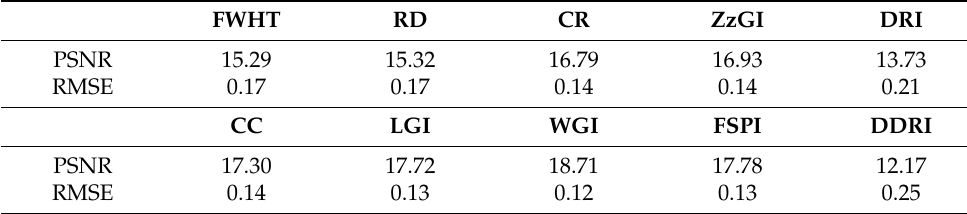
Table 6. PSNR and RMSE of images corresponding to the object “ 中 ” in Figure 9.